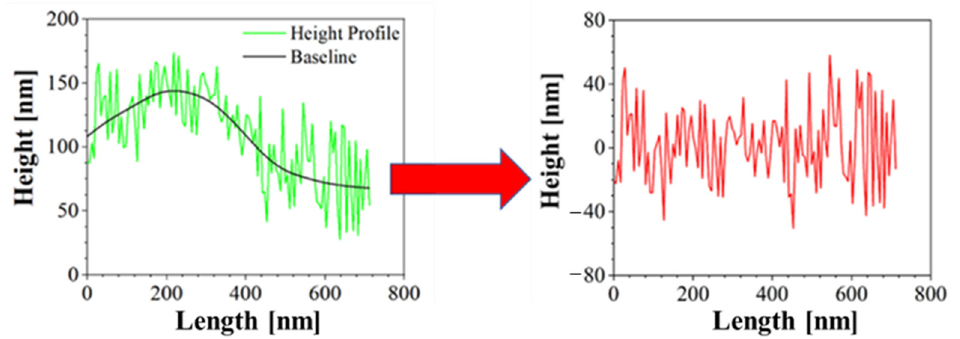
Figure 2. Correction of Height profile for roughness evaluation.